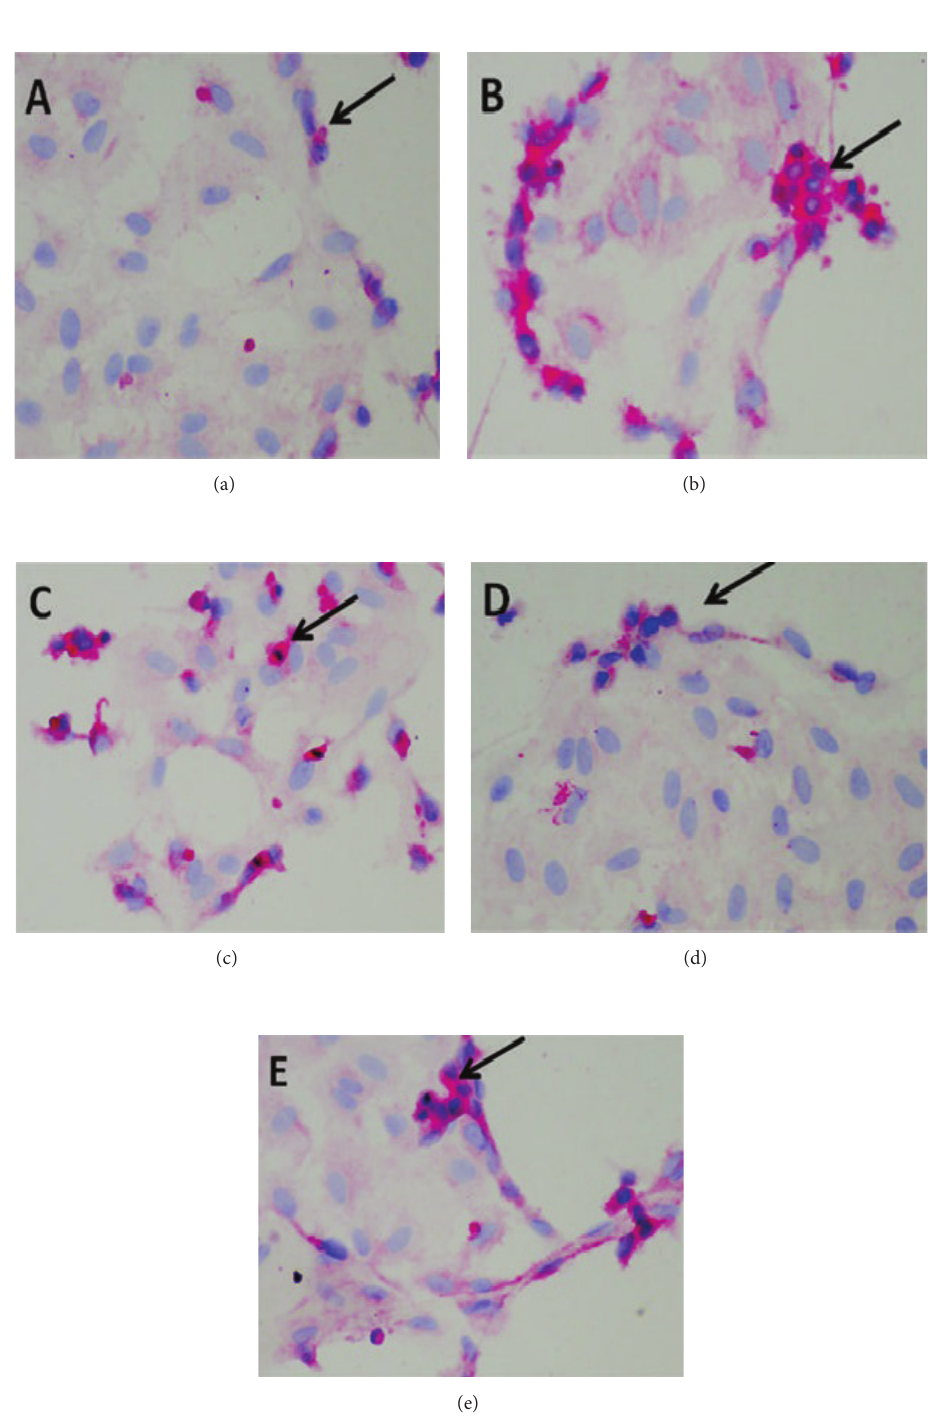
Figure 2: Representative micrograph of Angiotensin-II Type I receptor (black arrow) in endothelial cells induced by plasma preeclamptic patients. Endothelial cells exposed to 2% plasma from normal pregnancy (a), endothelial cells exposed to 2% plasma from preeclamptic patients (b), and endothelial cells exposed to PP in the presence of ethanolic extract of Punica granatum (PP + PG) at the following three doses: 14 (c); 28 (d); and 56 ppm